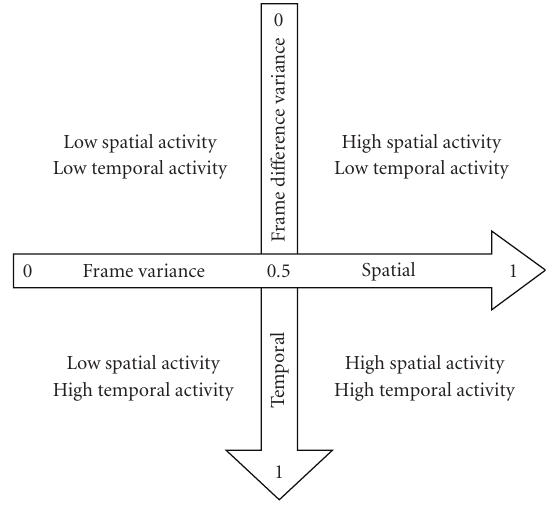
Figure 1: The Spatiotemporal